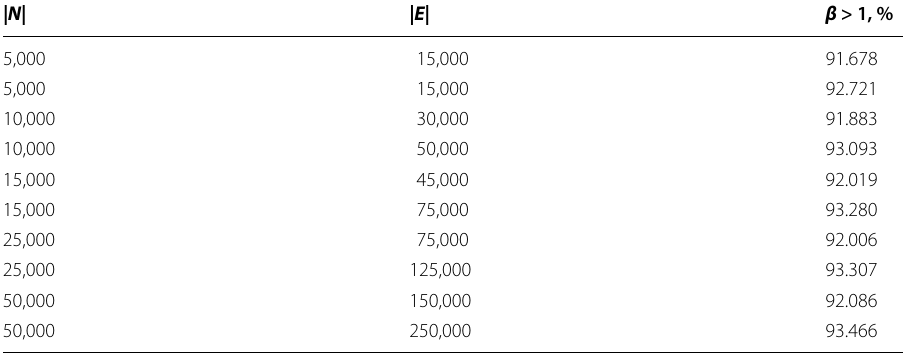
Table 5 Characteristics of friendship index distributions in synthetic networks generated with triadic closure